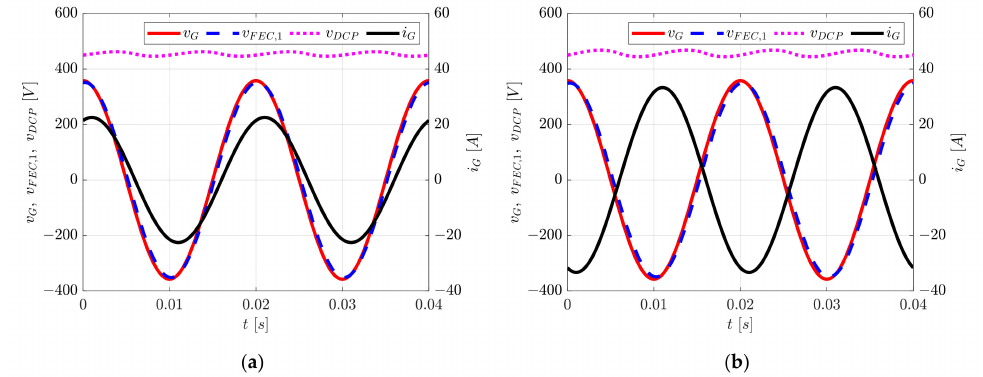
Figure 11. Grid-side voltage and current waveform in ( a ) charging and ( b ) discharging mode,